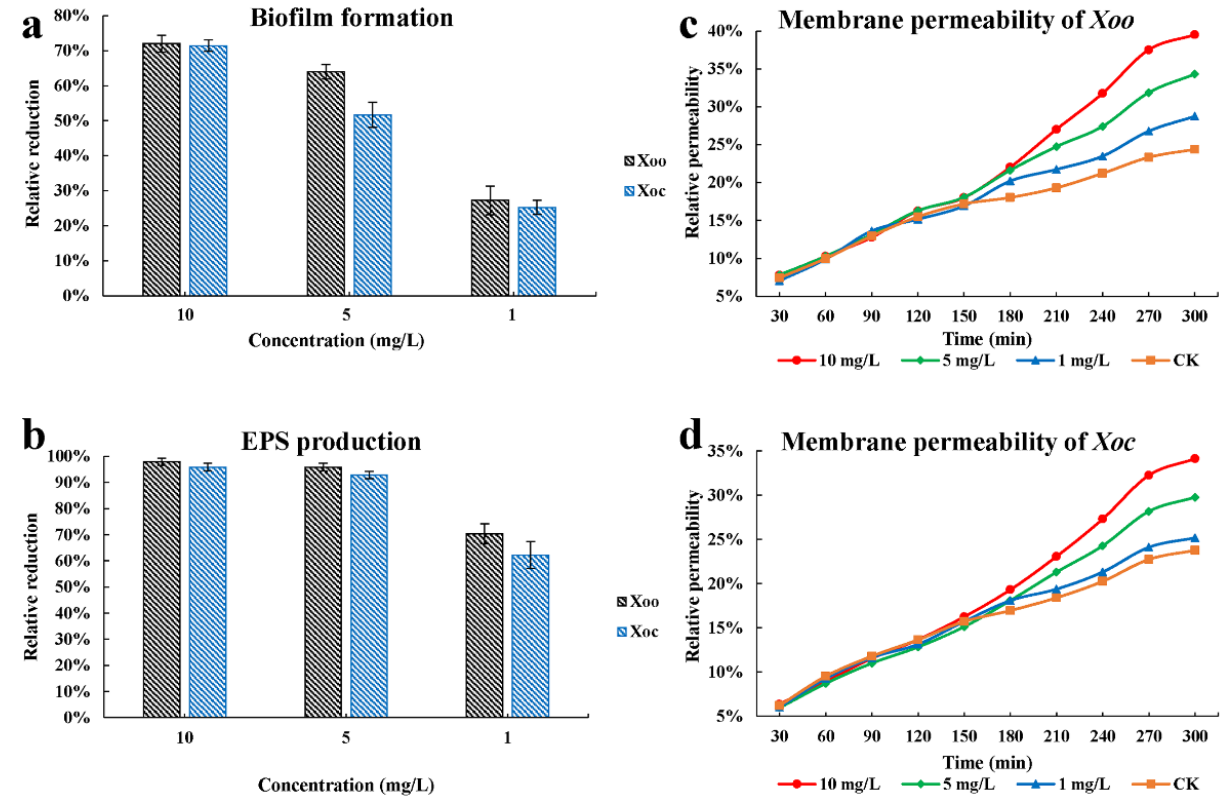
Figure 6. Effects of Xoo and Xoc on the biofilm formation ( a ), extracellular polysaccharide (EPS) production ( b ), and membrane permeability ( c , d ) at 10, 5, and 1 mg/L.